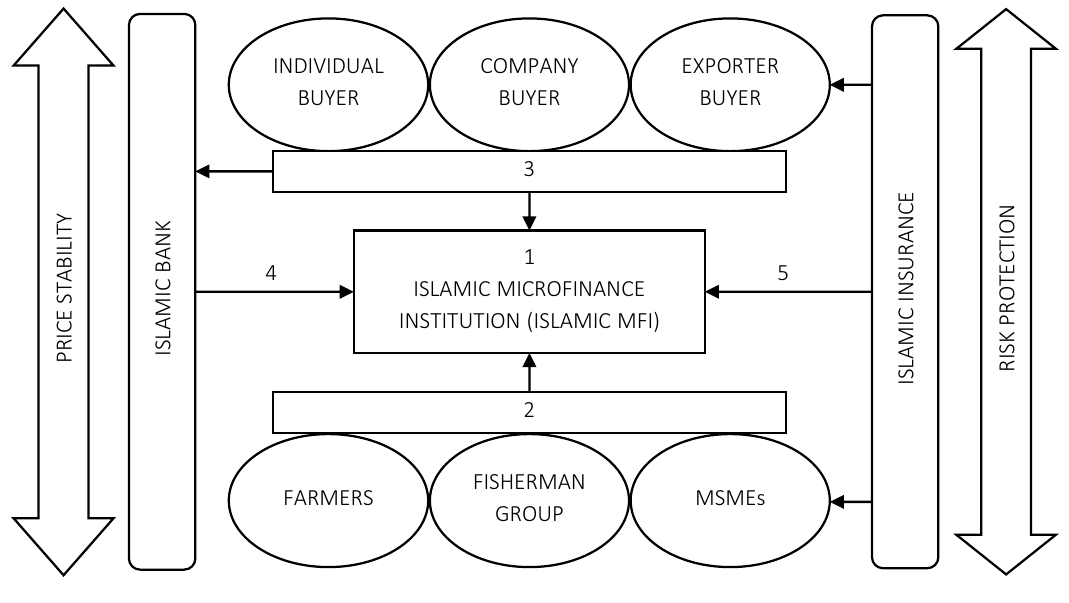
Figure 1. The model of reconstructing Salam for farmers and